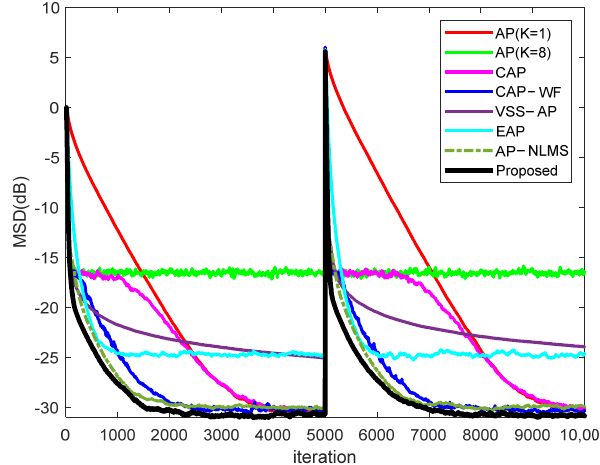
Figure 9. Convergence curves of the proposed algorithm and the conventional AP, CAP, CAP − WF, VSS − AP, EAP, and AP − NLMS algorithms in a non-stationary environment with SNR = 20 dB.